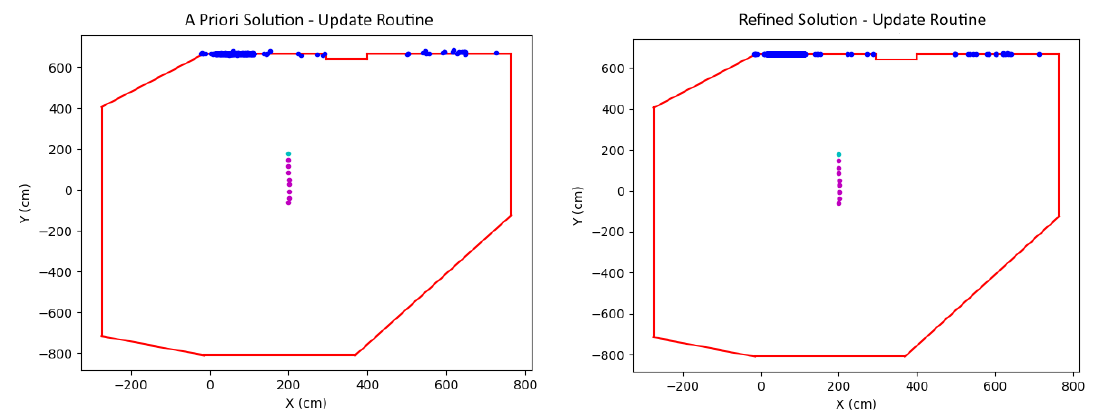
Figure 6. Update routine: new camera position (cyan) and world points before ( left ) and after ( right ) optimization.